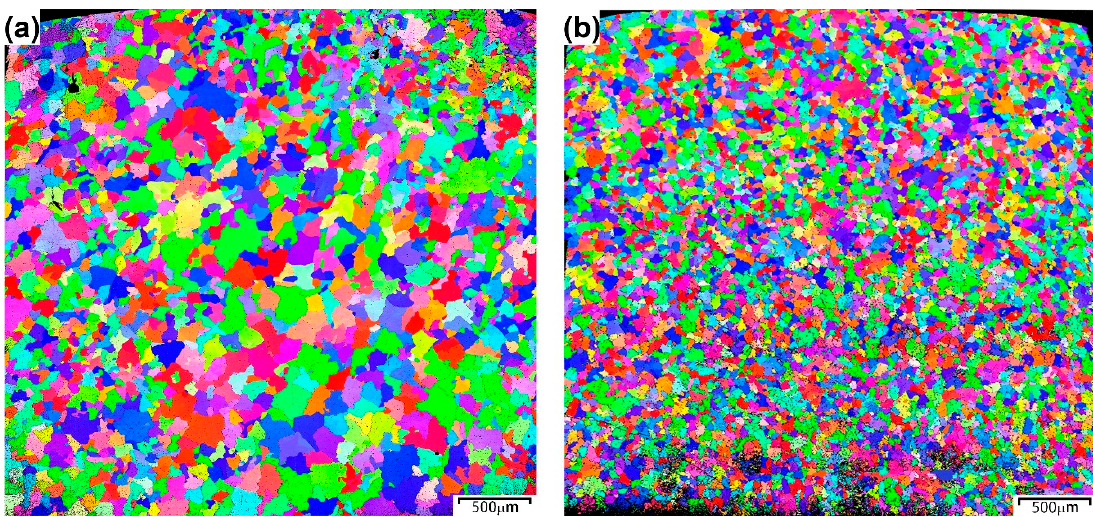
Figure 2. EBSD IPF maps of ( a ) RHEA and ( b ) RHEA-B samples showing the microstructure and different grain orientations.